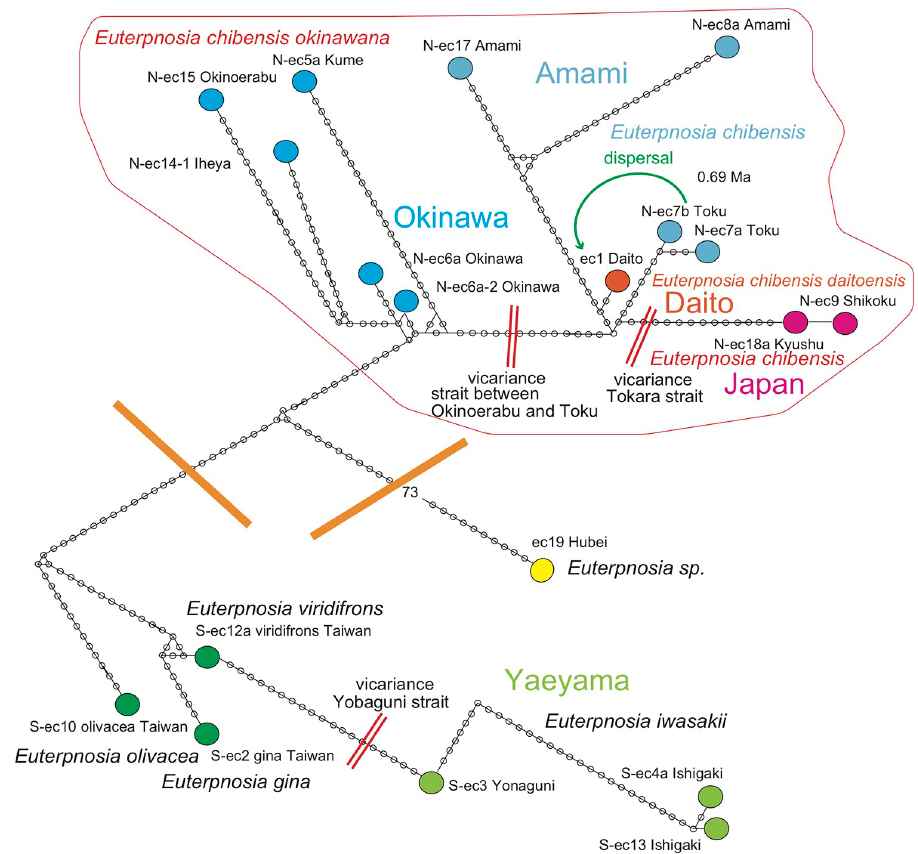
Fig 9. Haplotype network of Euterpnosia . The haplotypes were divided into E . chibensis okinawana (Okinawa) and E . chibensis networks, and the latter divided into the Amami and Japan networks, reflecting the 1.55 Ma event of vicariant speciation acted on the Ryukyu islands. However, E . chibensis daitoensis from the island of Daito was included in the Amami network, showing particularly close resemblance to the Toku network, suggesting that the Daito population was dispersed from the Tokuno-shima island at 0.72 Ma (Fig 6).